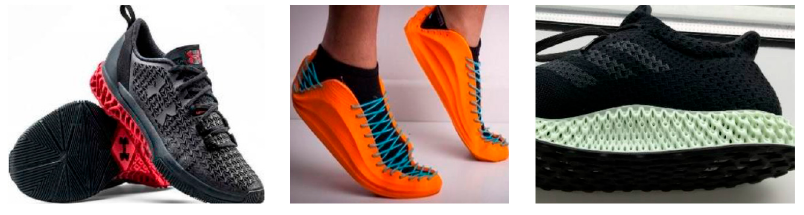
Figure 14. 3D printed sneakers [100].